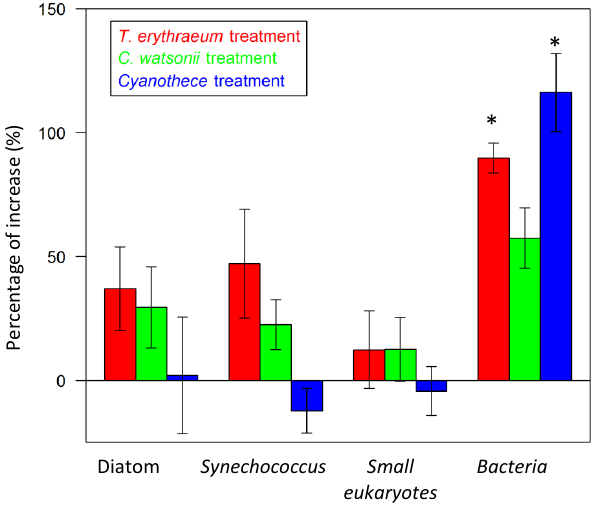
Figure 1. Relative increase of biomass associated with non- diazotrophic plankton groups considered in this study in the three diazotrophs-amended treatments relative to the control (%) after 48h of incubation. Errors bar represent the standard deviations on triplicate incubations of both diazotrophs-amended treatments and control treatment. ∗ Depict significant increase in biomass (un- paired Tukey HSD test, at 95% levels of confidence).